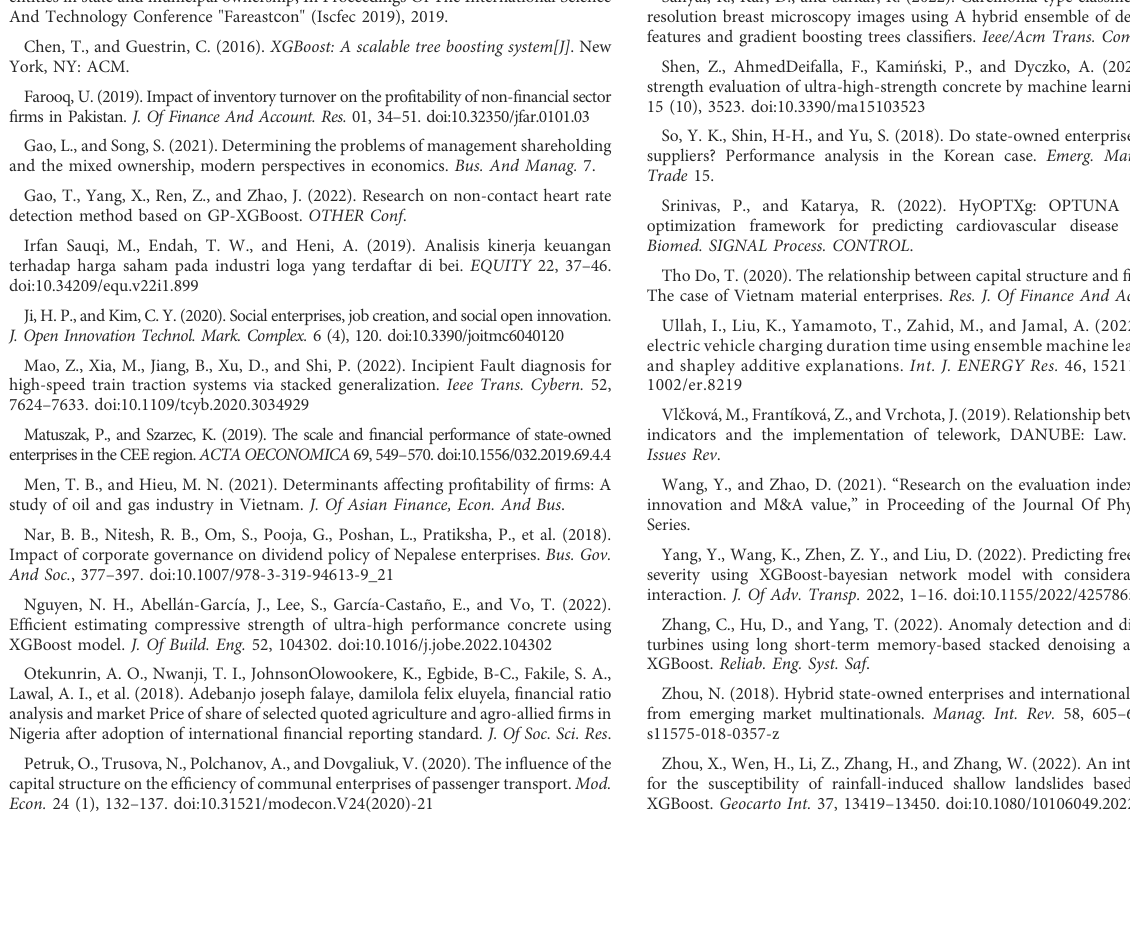
B і el і enkova, O. (2020). Factor analysis of pro fi tability (losses) construction enterprises in 1999-2019 . Chazova, I. Y., and Mukhina, I. A., Effectiveness of administration of economic entities in state and municipal ownership, In Proceedings Of The International Science And Technology Conference "Fareast s on" (Iscfec 2019),